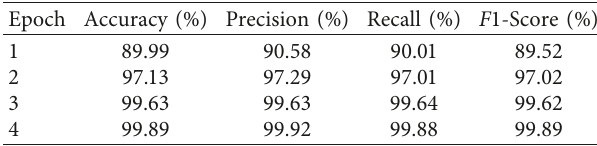
Table 7: Effect of the iterations on the model’s dataset